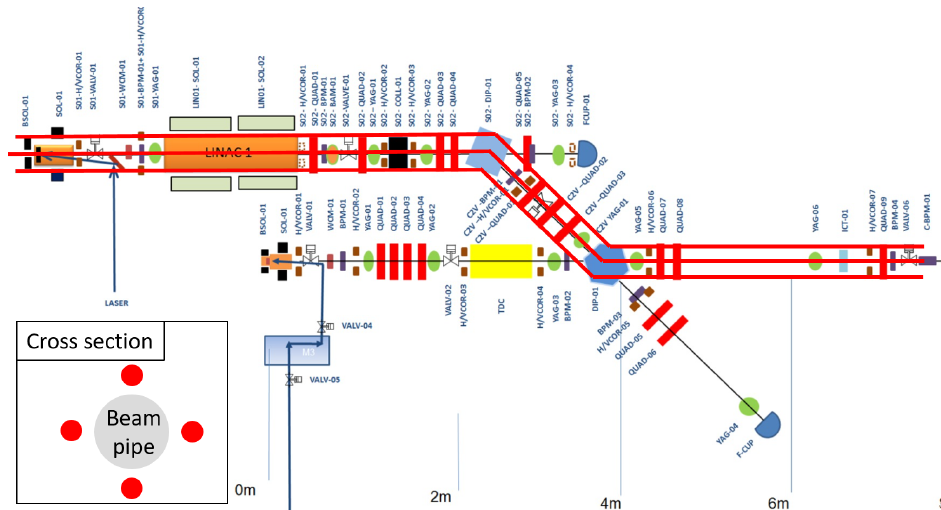
Figure 5. A schematic of the CLARA (STFC, UK) front end, and the approximate locations of the installed optical fibres (red).